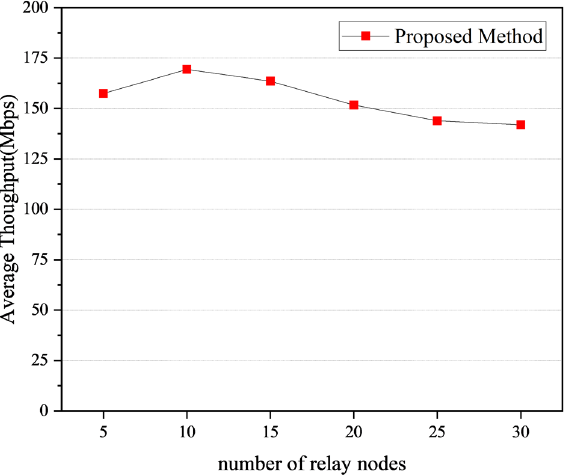
Figure 4. The average throughput under different number of relay nodes.